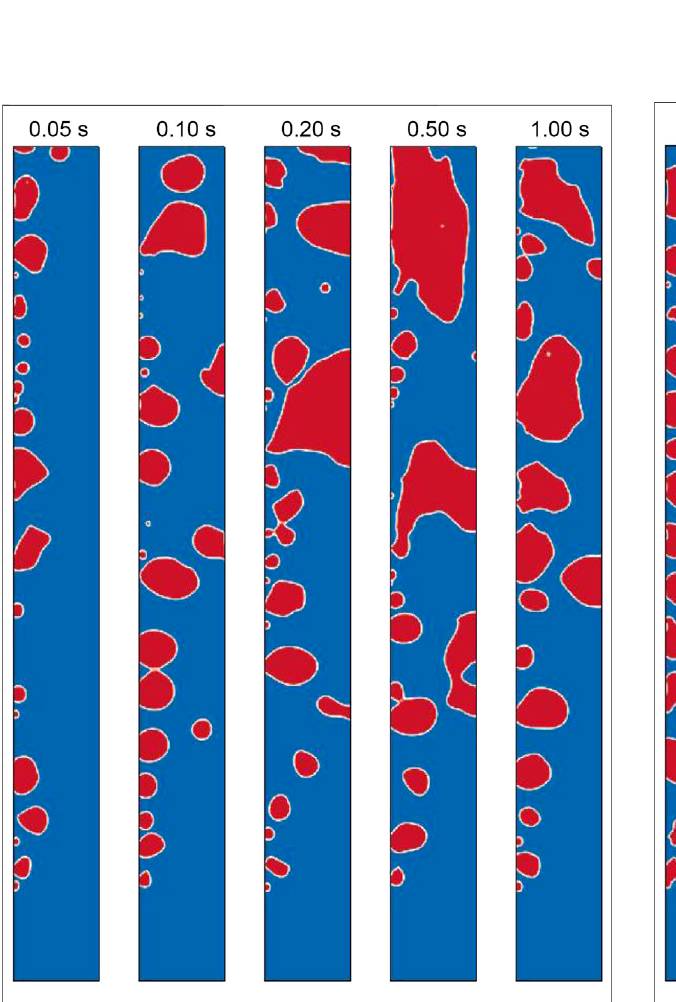
FIGURE 6 | Condensation of a small bubble in the bulk region.